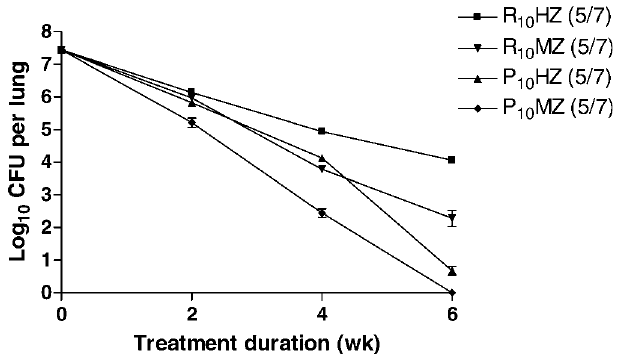
Figure 2. Bactericidal Activity of Daily (5/7) R 10 MZ, P 10 MZ, and P 10 HZ in Comparison to Standard Daily Therapy with R 10 HZ in M. tuberculosis – Infected